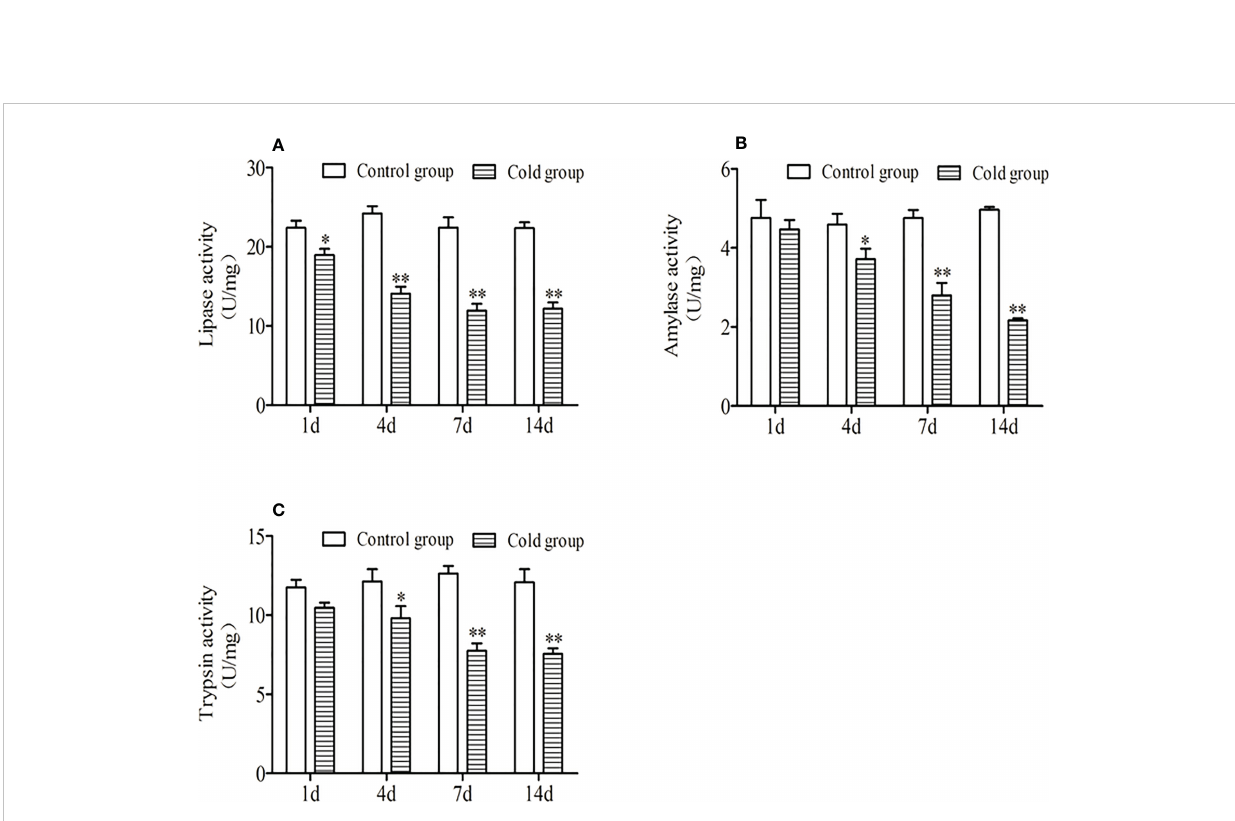
FIGURE 2 Effects of low-temperature stress on intestinal lipase activity. (A) ,amylase activity (B) and trypsin activity (C) of juvenile golden pompano. ** indicate signi fi cant difference at ( P < 0.01), * indicate signi fi cant difference at P < 0.05.